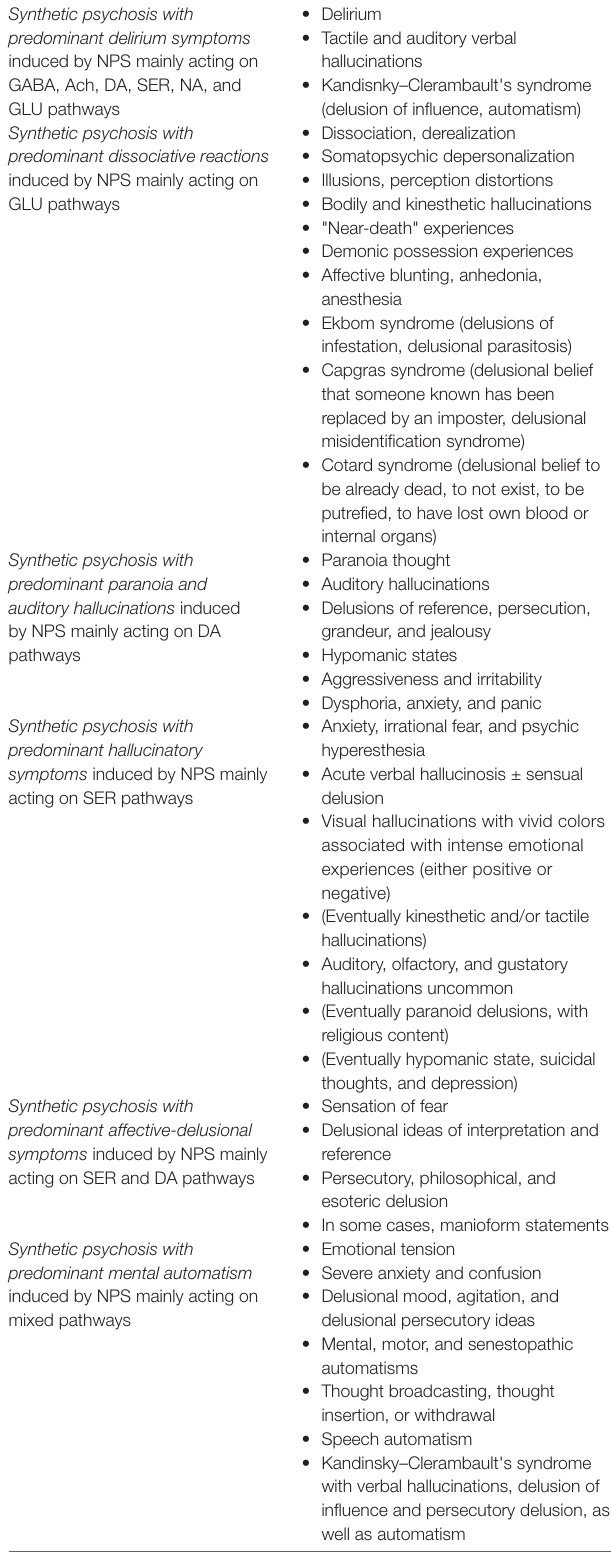
TABLe 4 | Clinical variants of NPS-induced